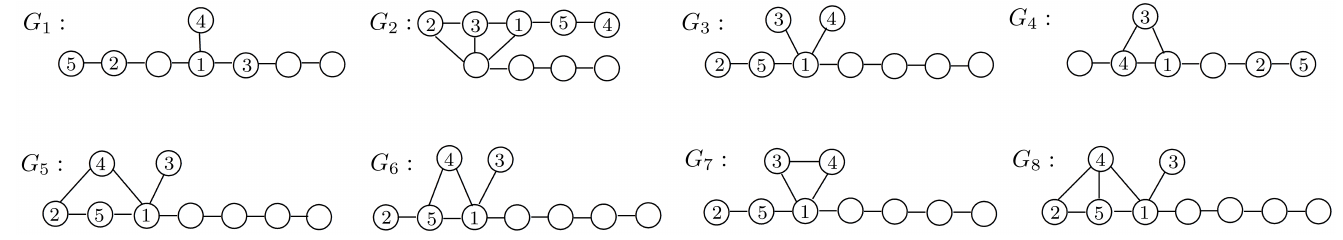
Figure 7: The eight graphs G